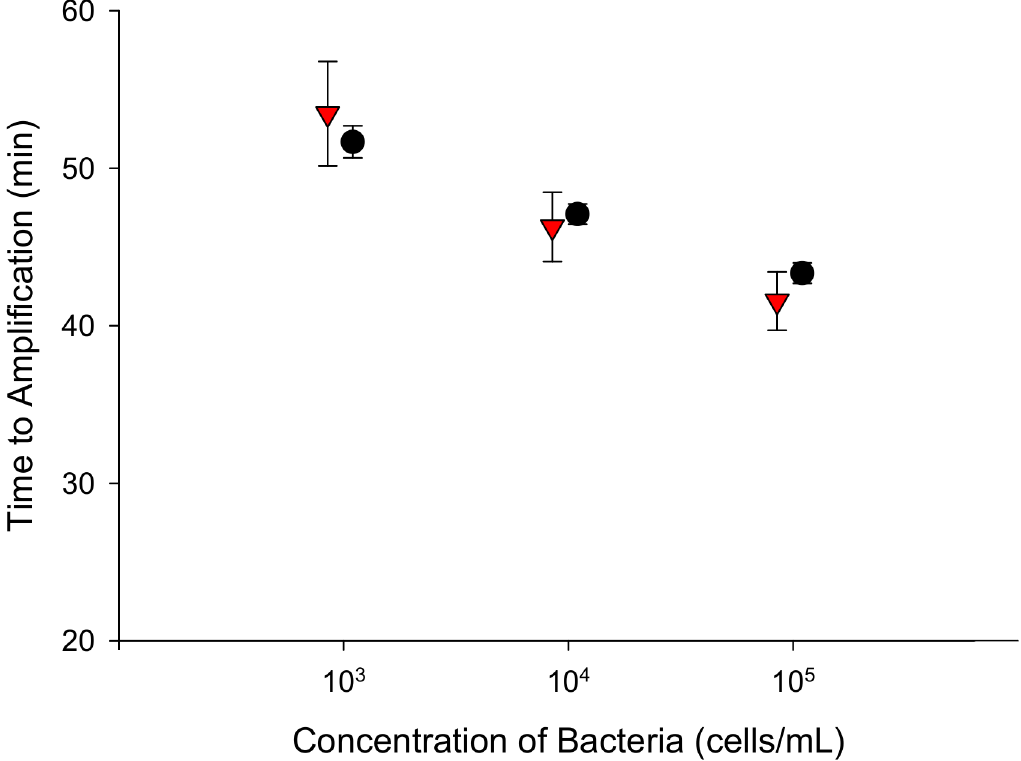
Fig 3. Time to amplification of TB DNA by LAMP and PCR. DNA was extracted from lysed surrogate sputum samples using the low-resource extraction technique and eluted into water. Eluent was amplified by LAMP (red triangle) and PCR (black circle); N =